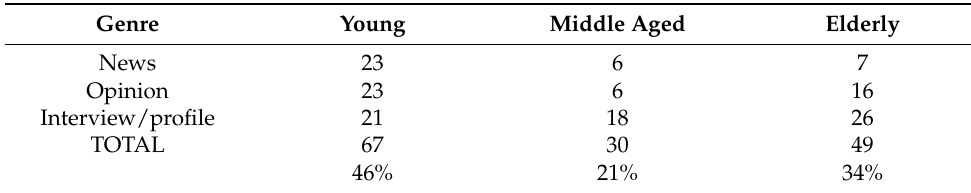
Table 2. Age and